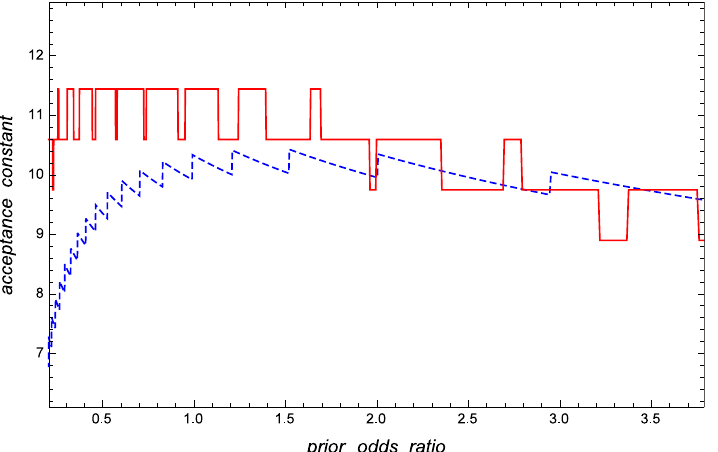
Figure 2. Optimal ( solid line ) and approximate ( dashed line ) acceptance constants, c ∗ and c a , versus the prior odds ratio when λ 0 = 0.3, λ 1 = 0.7, d 0 = d 1 = 1, α = 0.05 and β =